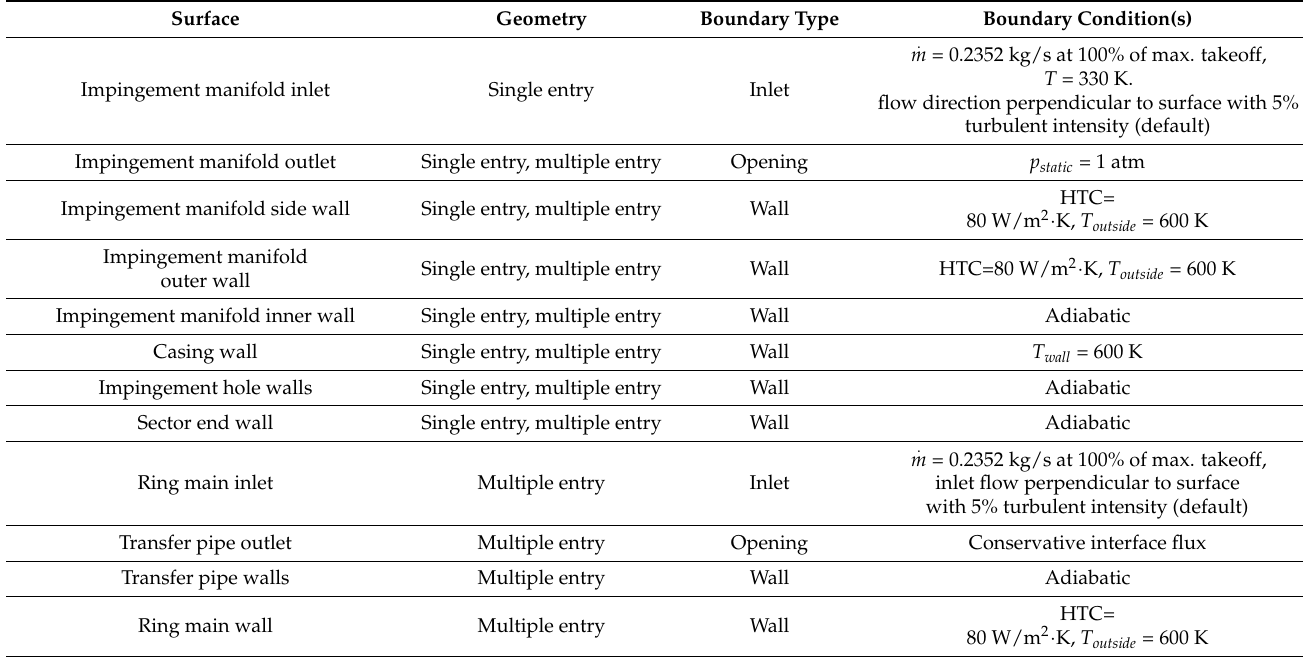
Table 1. CFD boundary conditions for both